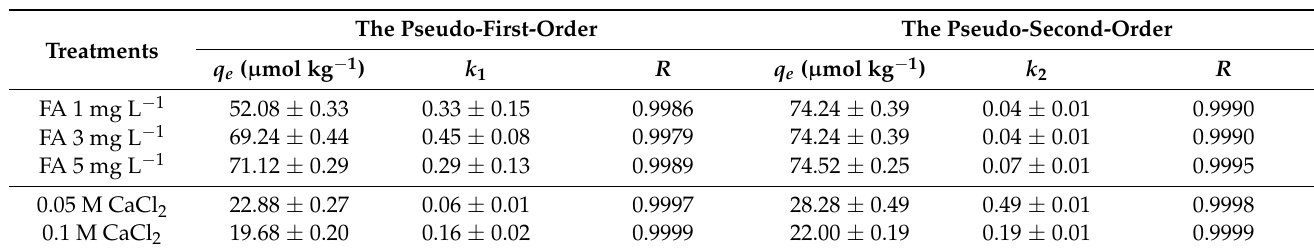
Table 3. Fitting results of the Linear and Freundlich models for adsorption curves of SDZ in various soil solutions (mean values ± standard error).